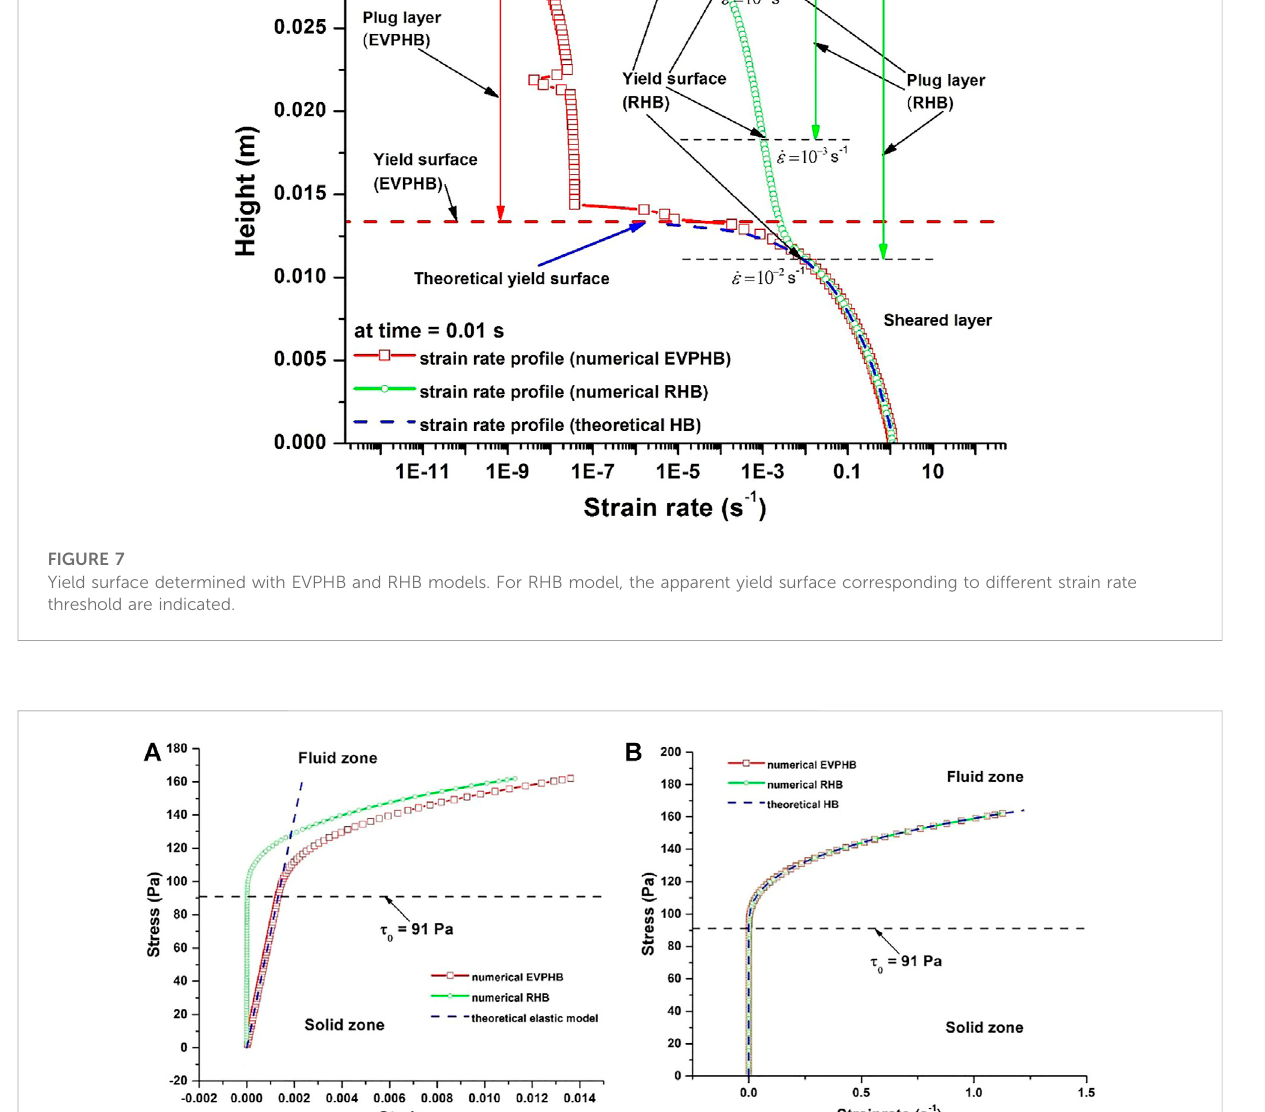
onto the theoretical HB constitutive curve, which indicates that both models can represent Herschel-Bulkley relation. In the solid zone, in spite of the stress changes, the strain rate is nearly zero. Therefore, from Figures8A,B itisagainreasonabletoconcludethattheEVPHB model is capable to accurately describe both elastic (linear stress and strain relation) and viscous (nonlinear stress and strain rate relation)